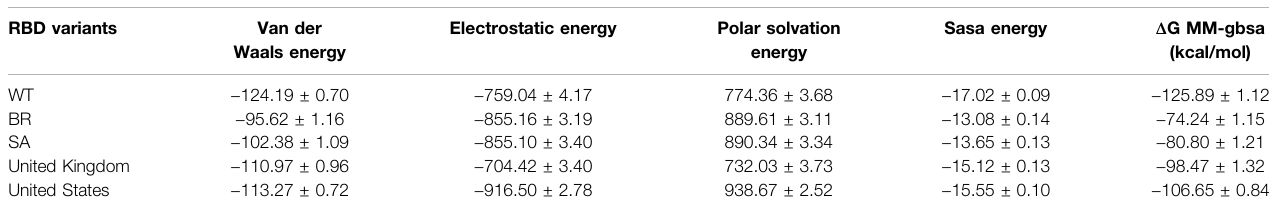
TABLE 6 | Free binding energy ( Δ G MM-GBSA) of bromelain and RBD complexes. RBD